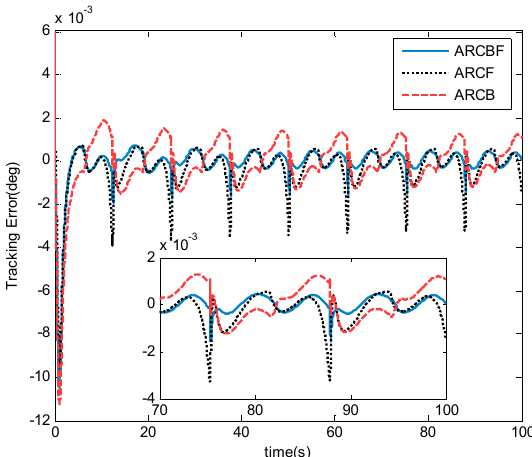
Figure 4. The compared tracking errors of the three controllers as ε = 1 × 10 − 6 .